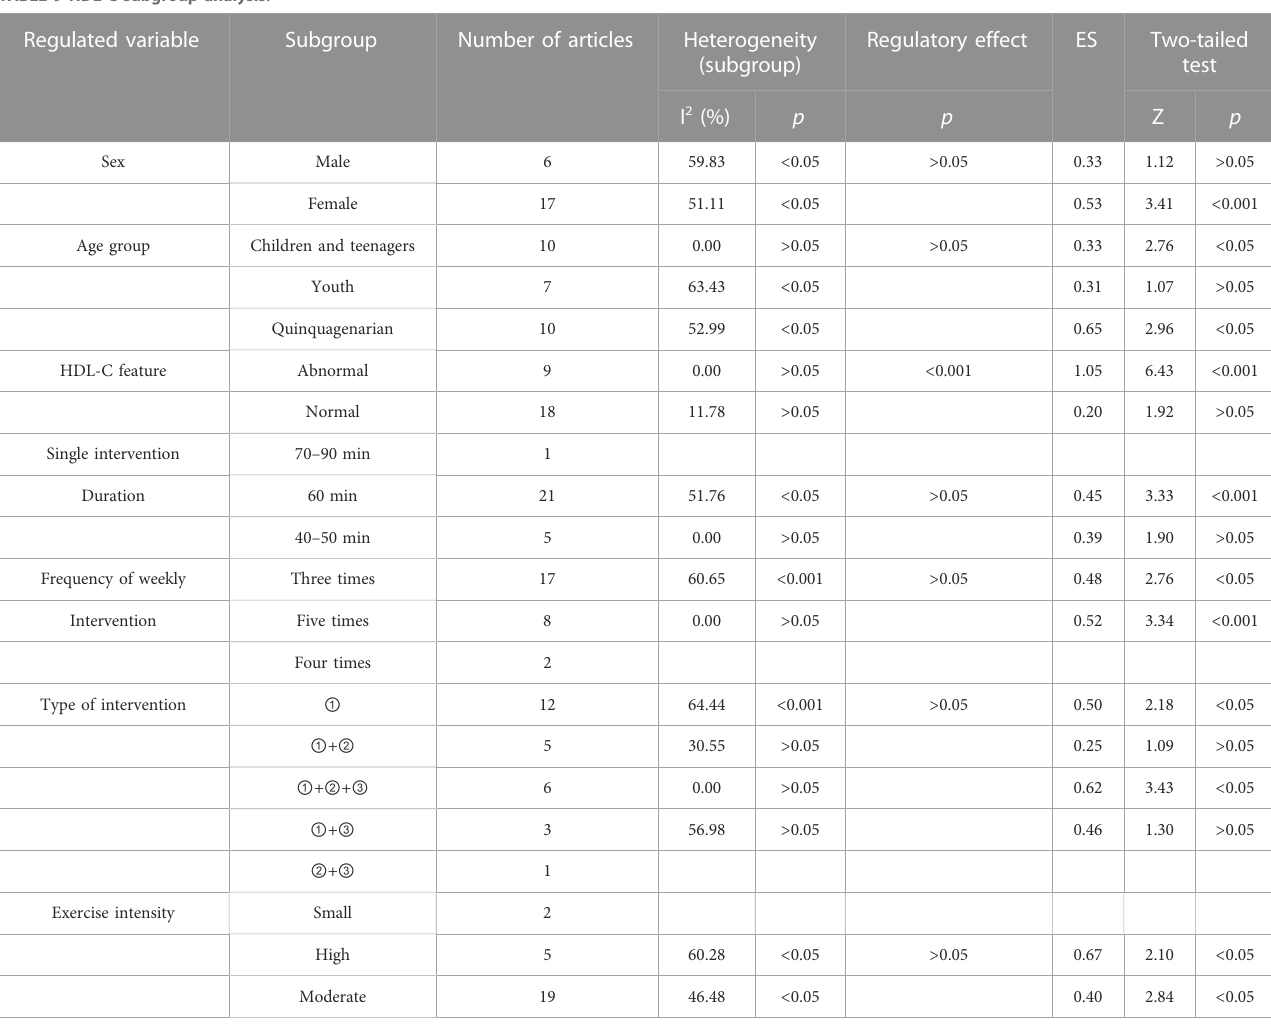
TABLE 9 HDL-C subgroup analysis.